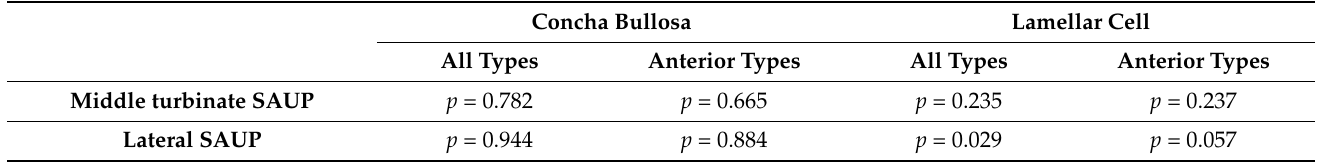
Table 1. p values for concha bullosa, lamellar cell and SAUP. (bold if statistically significant p < 0.05). Concha Bullosa Lamellar Cell All Types All